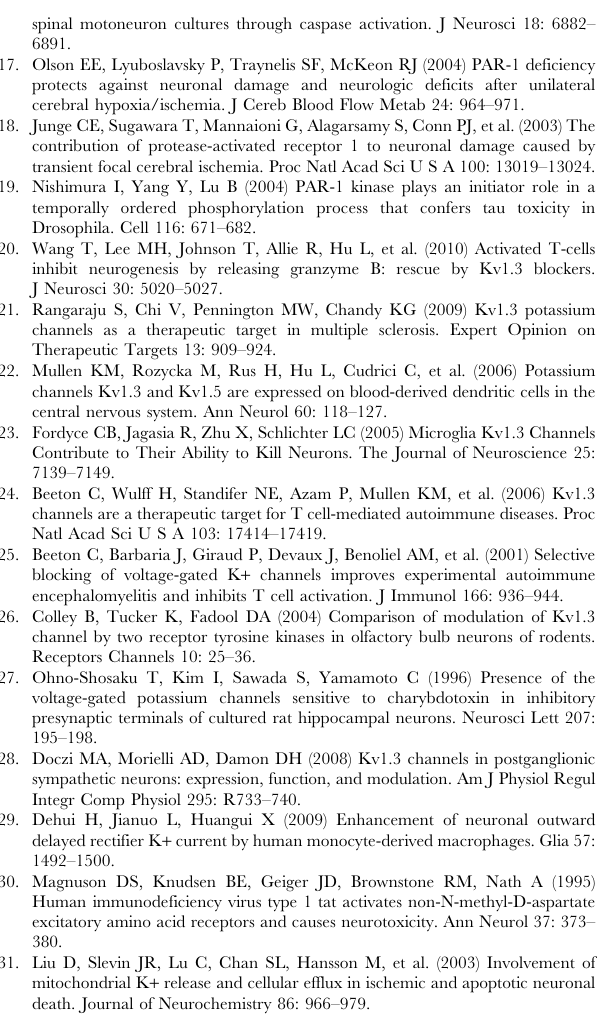
Figure S1 Effect of activated T cell supernatant on axons following incubation with neuronal cell body. Axonal fragmentation was observed in mouse cortical neurons after somal chamber was treated with human T-cell supernatant (A). No significant axonal fragmentation was observed in mouse cortical neurons after axonal chamber was treated with human T- cell supernatant (B). Axonal degeneration was not observed in control mouse cortical neurons after either chamber was treated with T-cell medium. Instead, growth was observed (C). Legend: (a) axons before treatment; (b) axons 72 hours after treatment. Figure S2 Effect of activated T cells supernatant on PAR-1 and Notch-1 activation. Primary cultured human fetal neurons were treated with supernatants (1:20 dilution) from CD3/ CD28 activated T cells (AT) or non-activated T cells (CT) for 3 and 18 hours. PAR-1 and activated Notch-1 fragment NICD were detected by Western-blot analysis. AT treatment group showed moderately decreased PAR-1 and significantly increased NICD after 3 hours of treatment and significantly decreased PAR-1 after 18 hours, compared to CT.